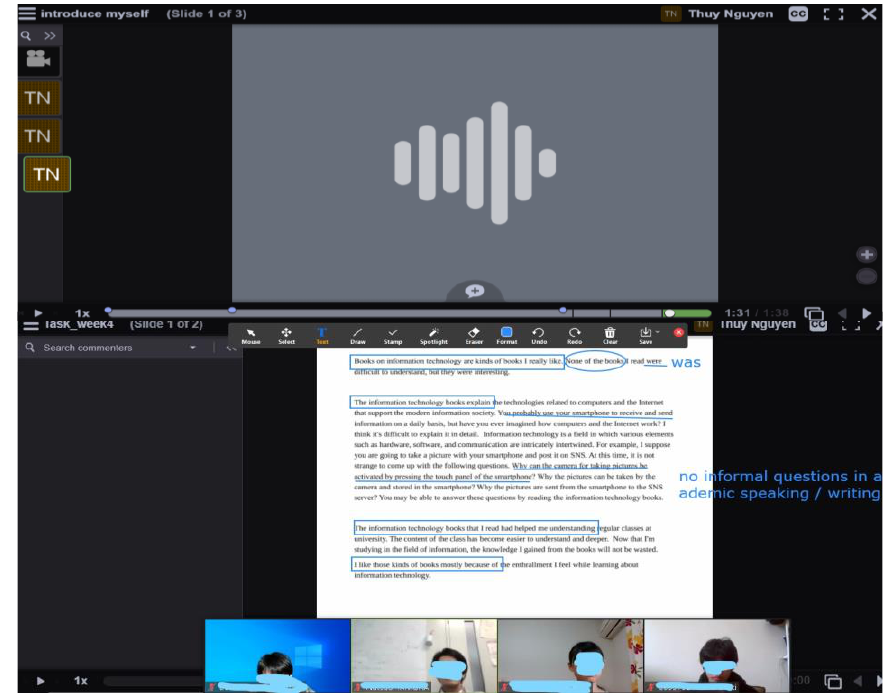
Fig. 2. Example of VoiceThread and zoom